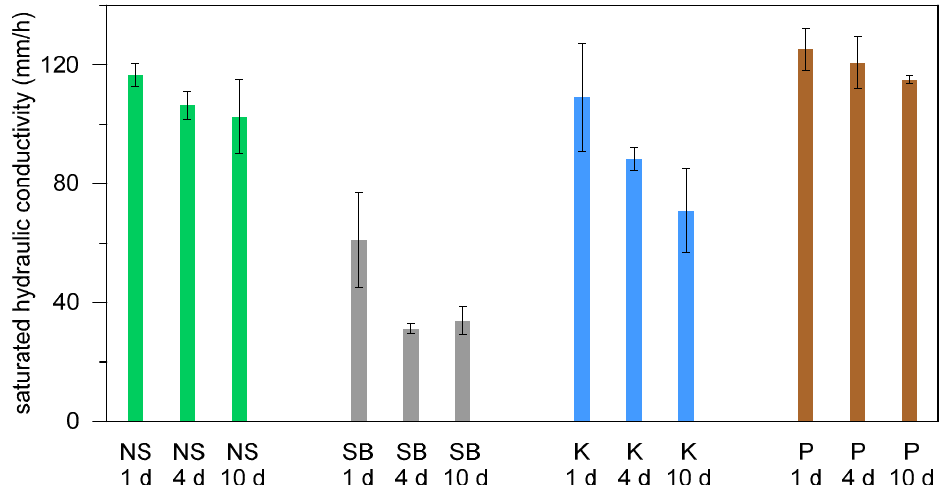
Figure 6. Average saturated hydraulic conductivity values during intermittent infiltration-outflow experiments in four different soil columns. The abbreviations represent columns from North Shore (NS), Sandy Beach (SB), Kunia (K), and Pali (P). The numbers below the columns indicate the time (days since start of the experiment) when the evaluation of the saturated hydraulic conductivity was performed. The error bars represent standard deviations.